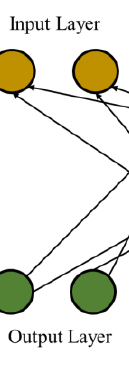
Figure 1. Feed forward back propagation network.